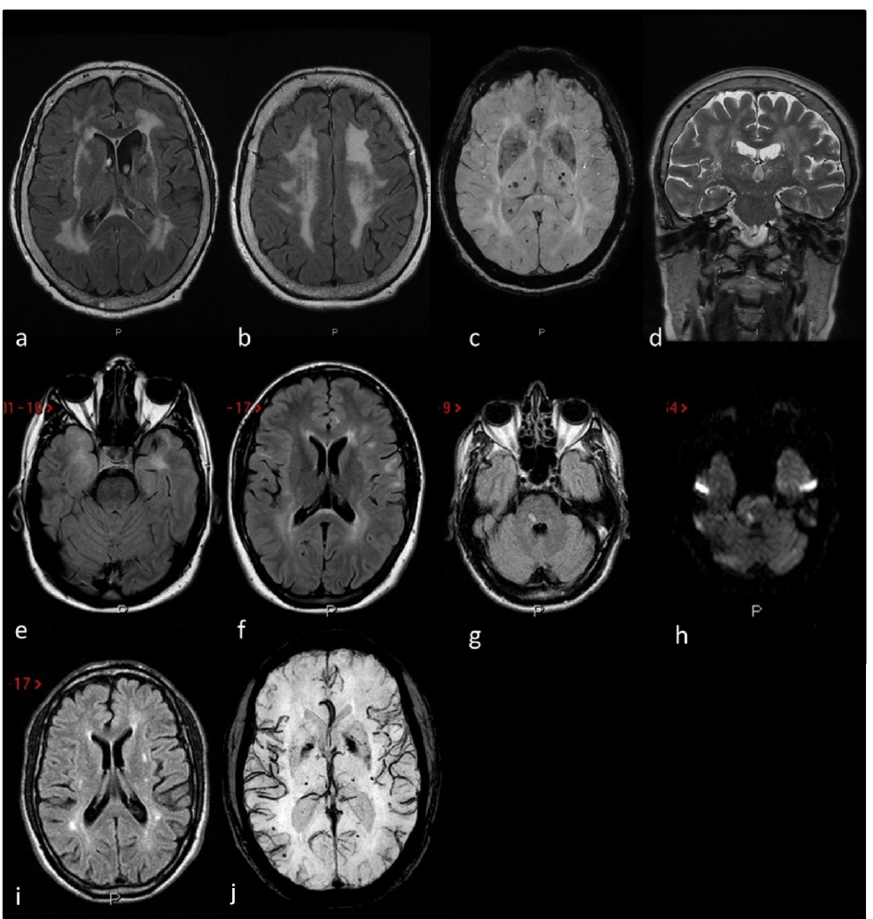
Figure 4. MRI markers of small vessel disease in three CADASIL patients: Patient 1 ( a – d ) severe leukoaraiosis involving subcortical white matter, external capsule and periventricular regions in a symmetrical pattern on axial FLAIR ( a , b ) MRI, associated with deel and lobar supratentorial microbleeds on SWI (axial MiP sequences) MRI ( c ) and enlarged perivascular spaces in the basal ganglia on coronal T2W ( d ) MRI. Patient 2 ( e , f ) anterior temporal lobe involvement ( e ) and periventricular and iuxtacortical white matter hyperintensities ( f ) on axial FLAIR MRI. Patient 3 ( g – l ) recent subcortical ischemic stroke on the right portion of the pons on FLAIR ( g ) and DWI ( h ) MRI sequences, supratentorial white matter hyperintensities with a dotted distribution involving the external capsule and the periventricular regions on axial FLAIR ( i ) MRI and multiple supratentorial deep and lobar microbleeds on SWI (MiP sequences) MRI ( l ).